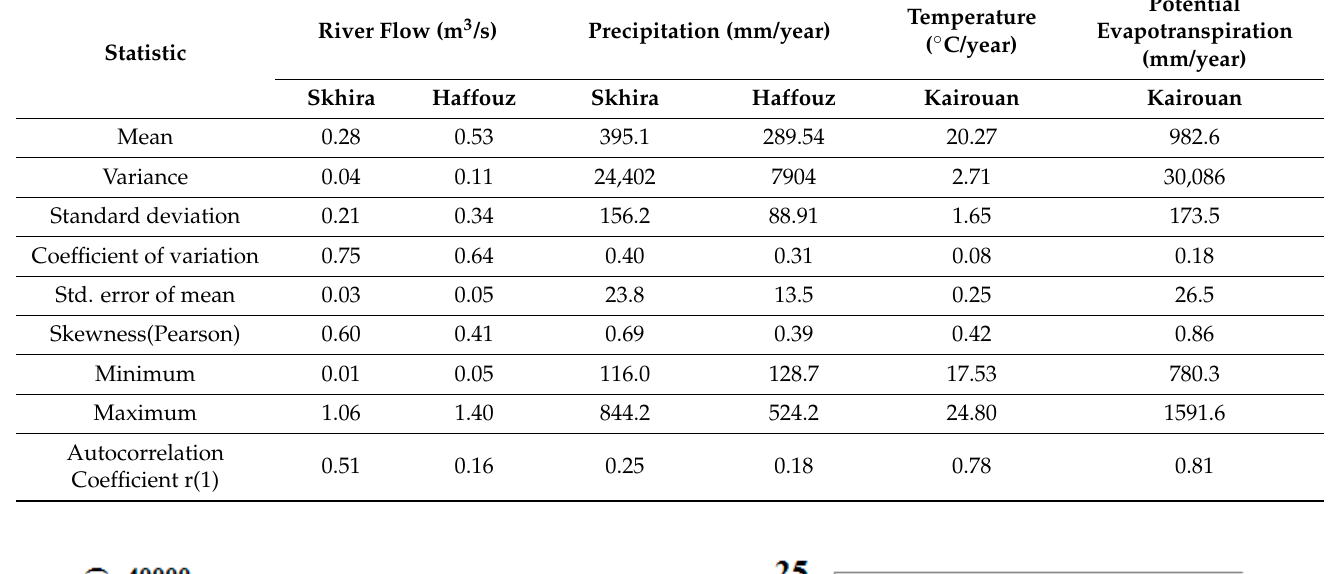
Table 2. Descriptive statistics of data used for the study period (1976 – 2017).